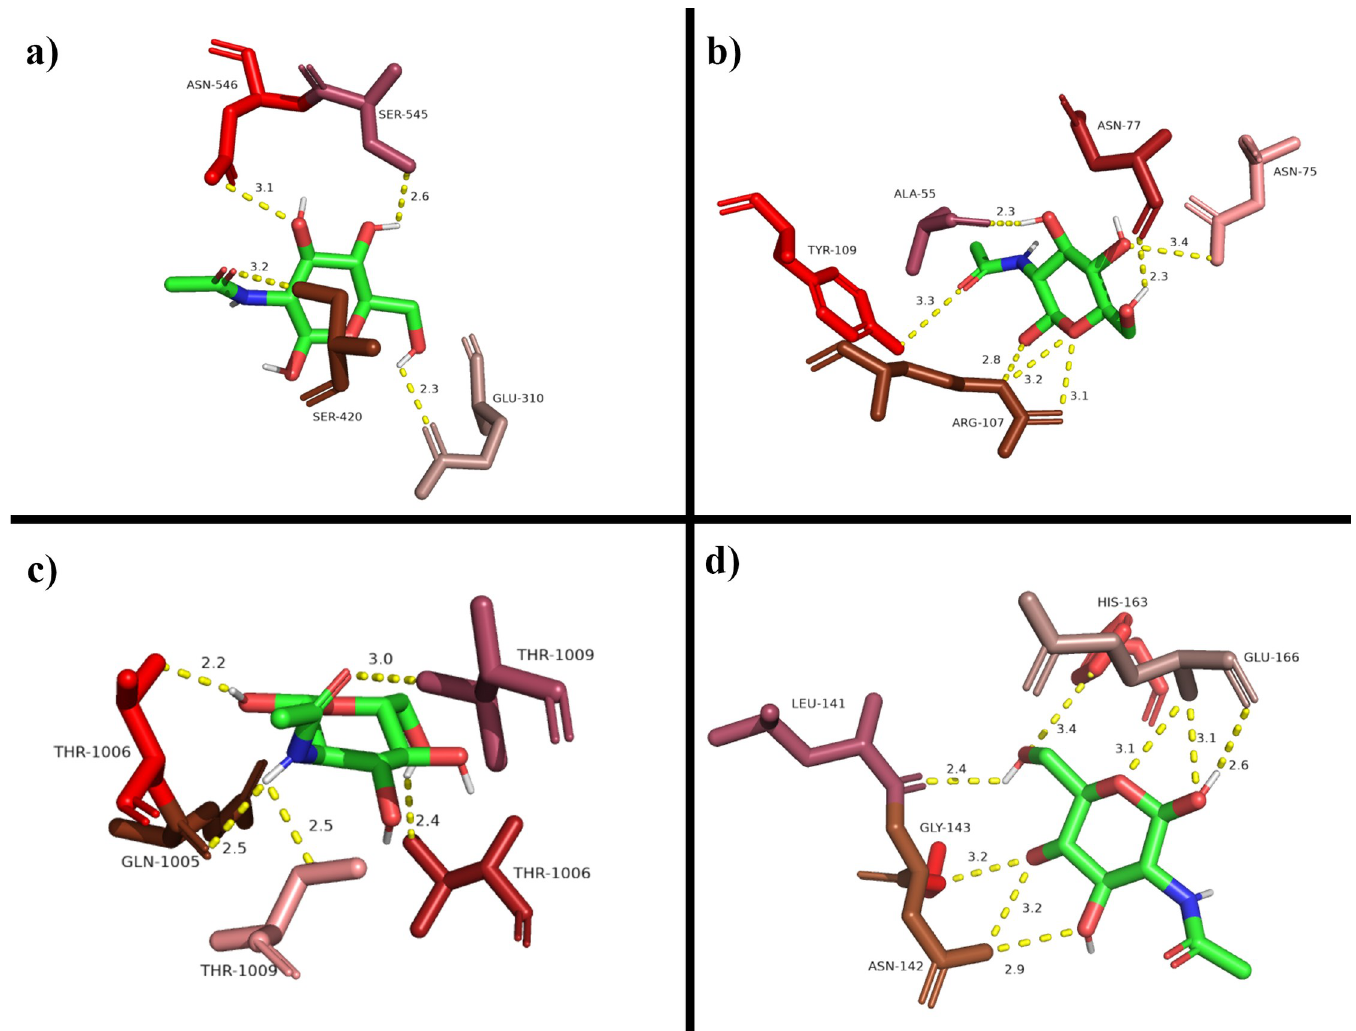
Fig 4. All potential polar interactions between D-GlcNAc (green stick) with a) 6M0J, b) 6WKP, c) 6X79 and d) 7JVZ with 5 Å from D-GlcNAc as predicted by PyMol. The interactions between the residues as shown by yellow dots (length in Å ). The amino acid residues are colored randomly for contrast.